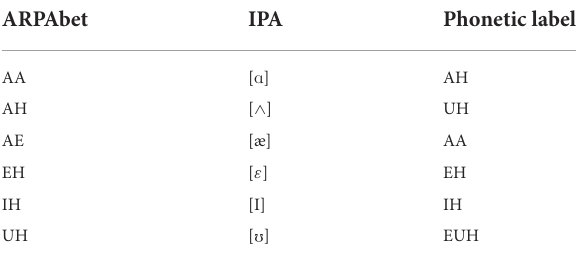
TABLE 1 Conversion table from ARPAbet to phonetic spelling used in paradigm. ARPAbet